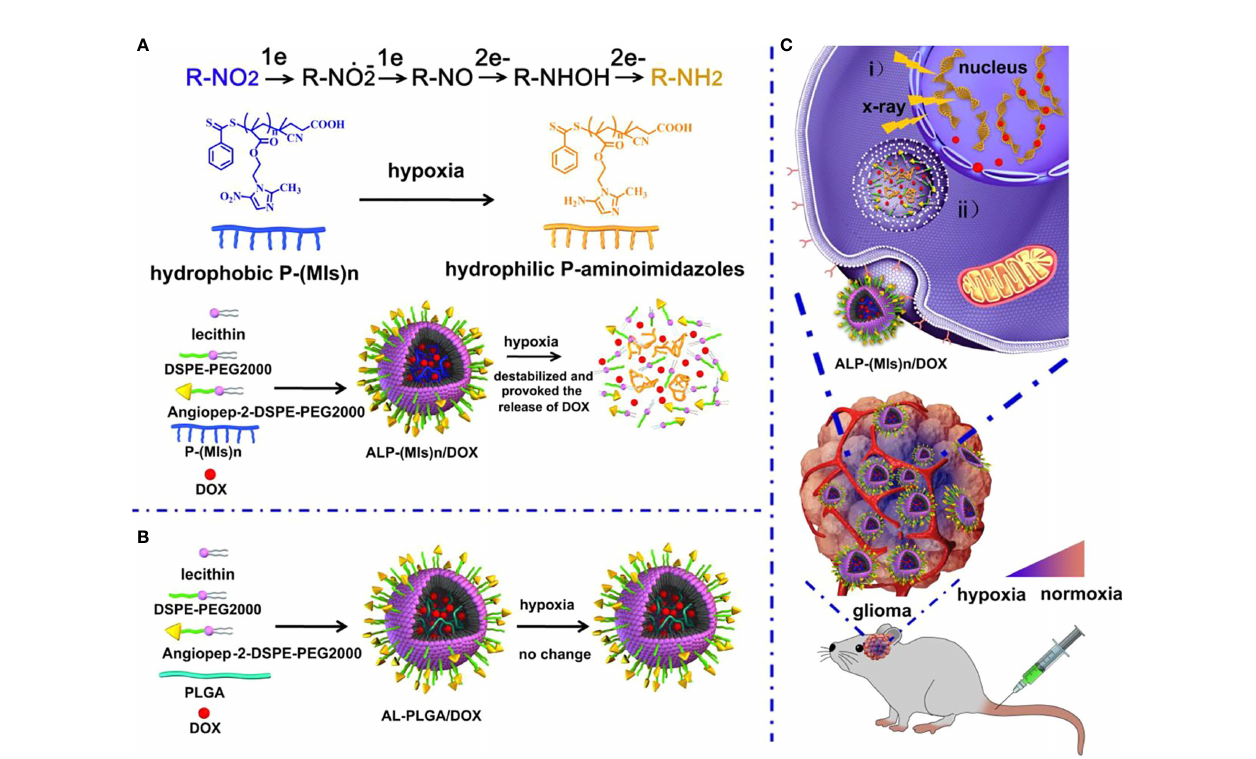
FIGURE 1 | Schematic of the hypoxia-responsive and hypoxia RT sensitization ALP-(MIs)n drug-delivery system. (A) Mechanism of ALP-(MIs)n RT sensitization and DOX release under hypoxic condition and formation of ALP-(MIs)n/DOX. Six electrons are transferred in the complete reduction of nitro (R-NO 2 ) to amine (R-NH 2 ) under hypoxic conditions via a single-electron reduction catalyzed by a series of intracellular nitro reductases. (B) Formation of AL-PLGA/DOX as the control group. (C) Schematic illustrating ALP-(MIs)n applications: (i) Hypoxic cell radiosensitizer. ii. Hypoxia-responsive release of DOX into the cytoplasm, and then transports it to the nucleus to kill tumor cells (47).